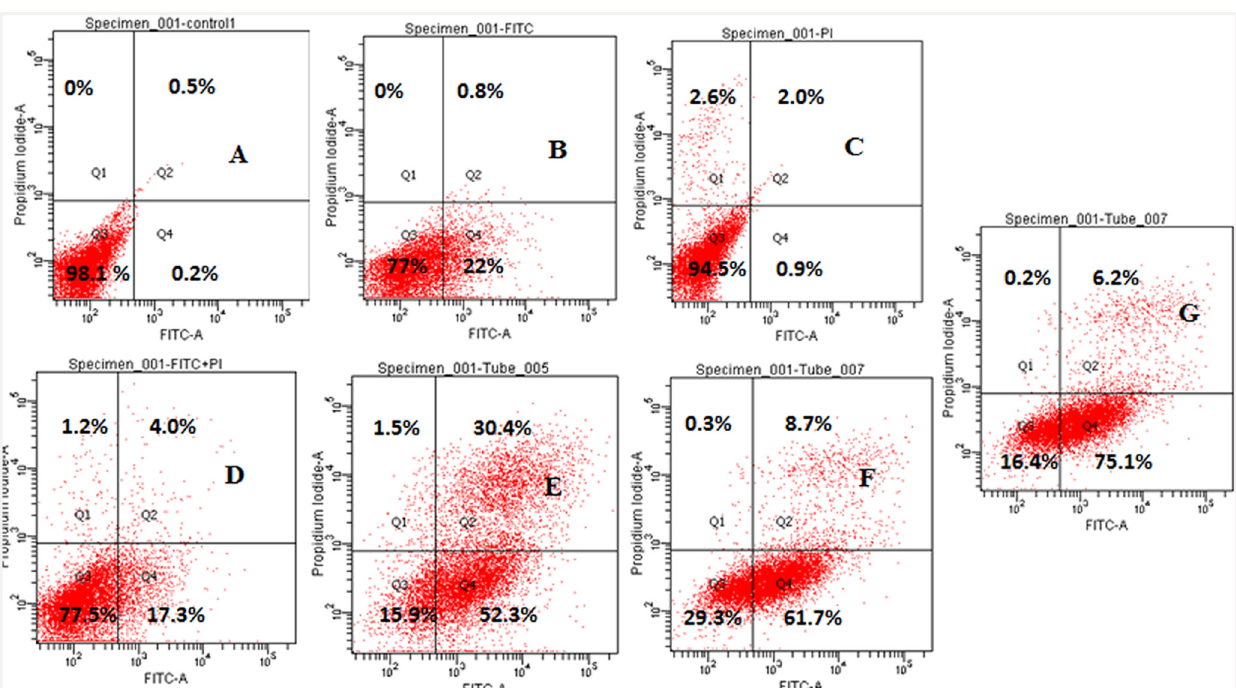
Fig 15. Induction of apoptosis in HeLa cells treated with different concentrations of ‘ fungal VCR ’ , as determined by annexin V-FITC/PI dual staining. A- untreated cells, B — cells + FITC, C — cells + PI, D — cells + FITC + PI, E — cells + FITC + PI + fungal VCR (5 μ g/ml), F — cells + FITC + PI + fungal VCR (10 μ g/ml), G — cells + FITC + PI + fungal VCR (25 μ g/ml) and H — percentage of cells undergoing early